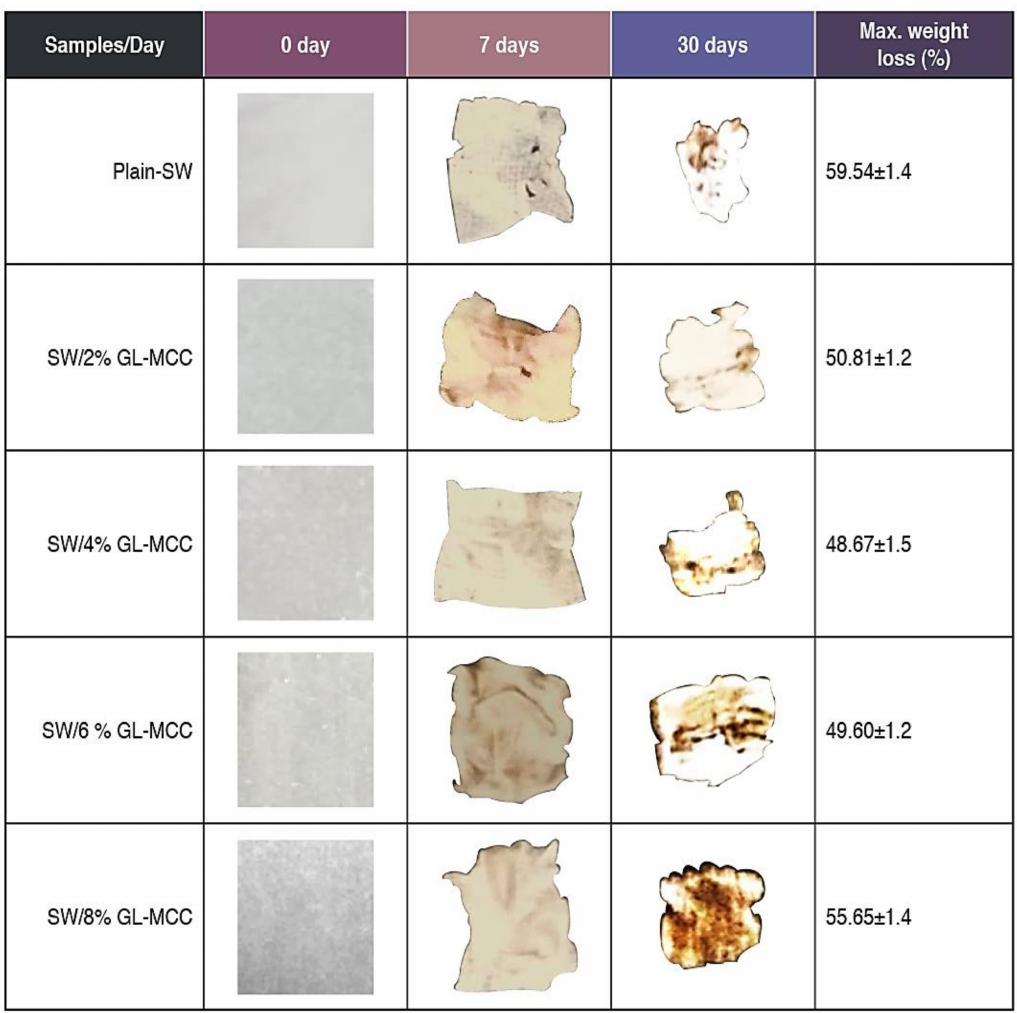
Figure 8. Changes of the appearance of SW / GL-MCC biopolymer films before and after soil-burial